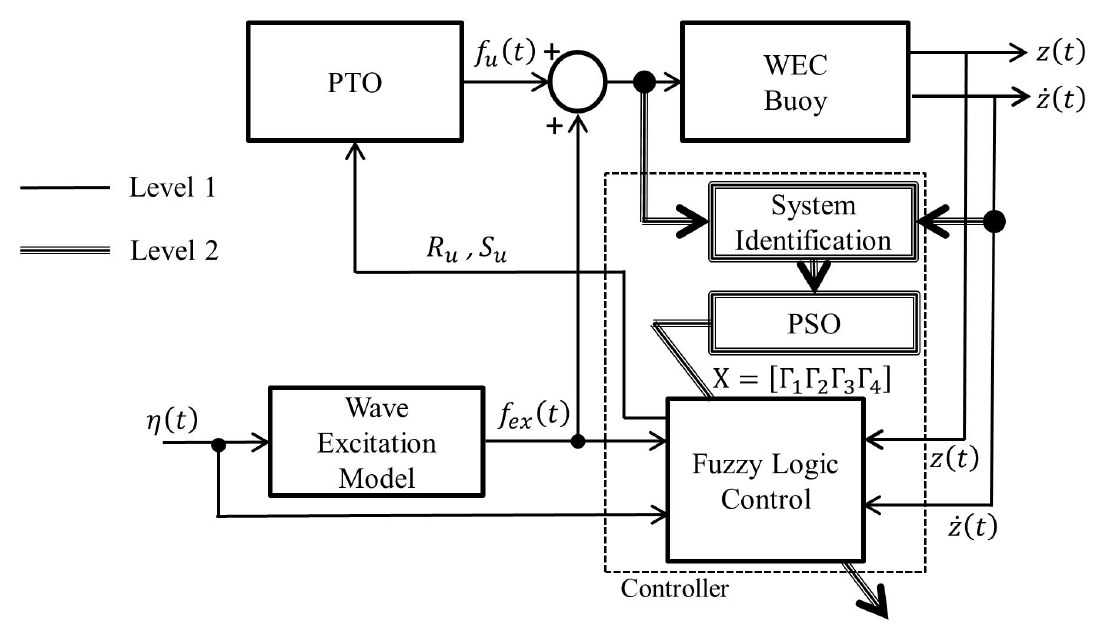
Figure 3. Block diagram of the proposed PSO-FLC